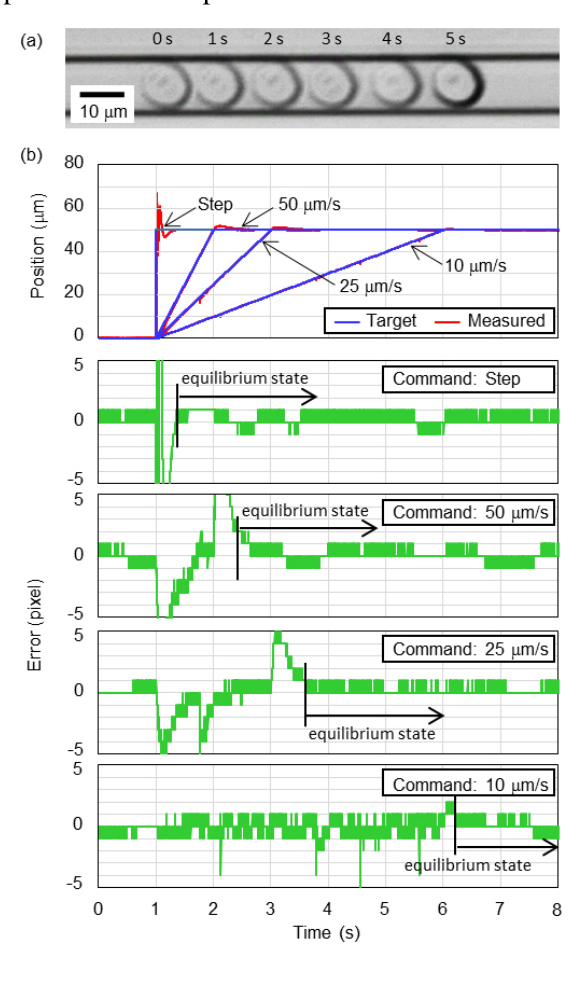
Figure 5. Demonstration of cell positioning. ( a ) An example of cell position control and ( b ) the measured cell position with respect to